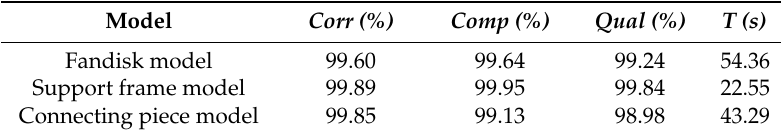
Table 5. Result of evaluation and execution time of feature surface